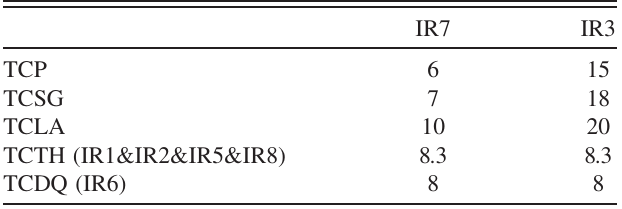
TABLE III. The half gap of the different group of LHC colli- mators (in unit of rms beam